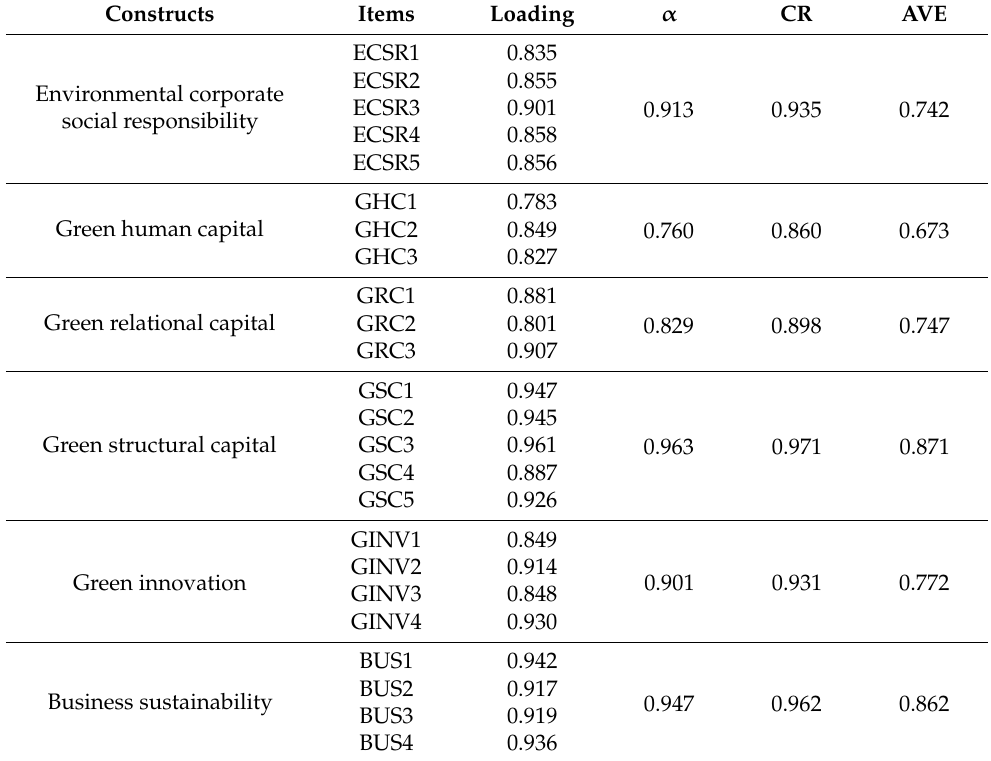
Table 4. Descriptive Analysis and Measurement Model.